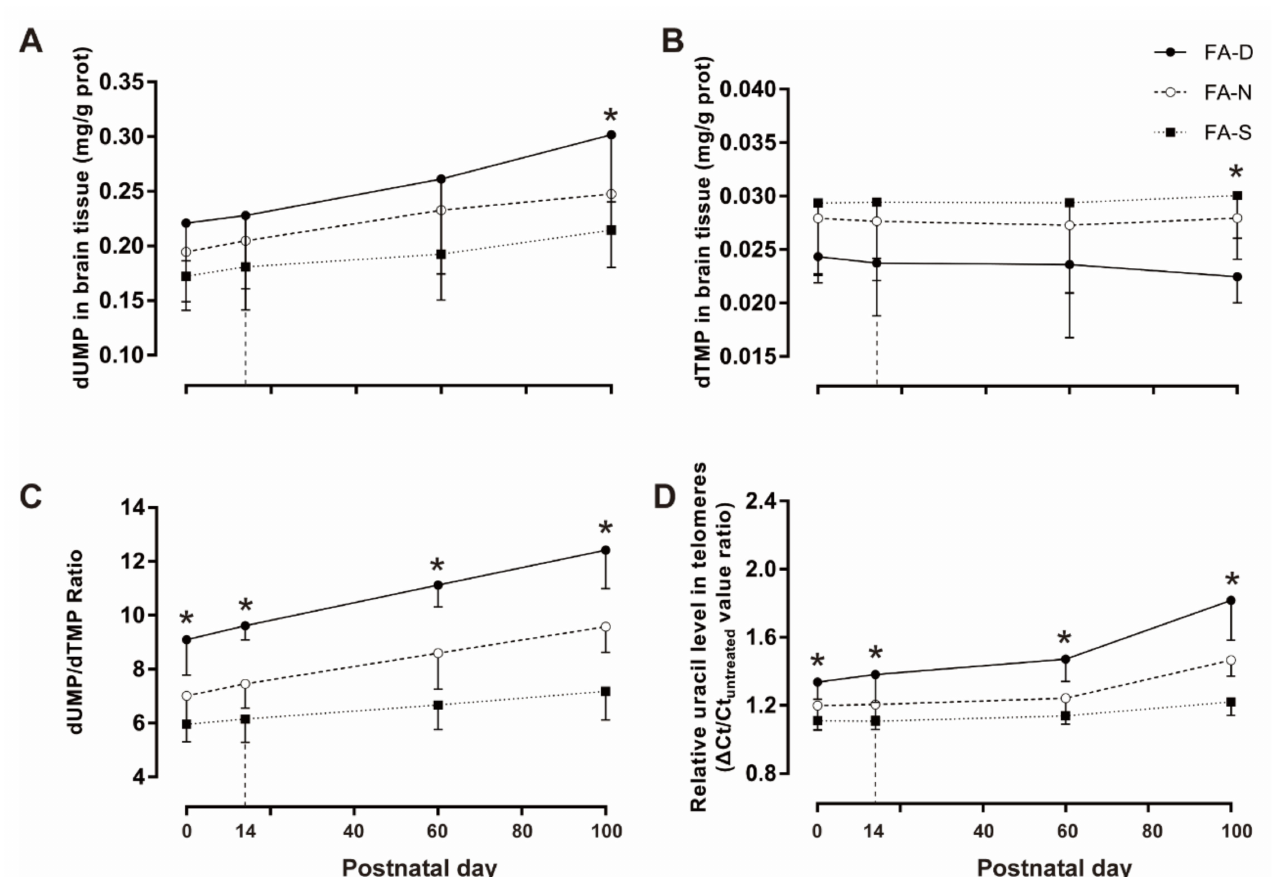
Figure 5. Folic acid supplementation reduced uracil misincorporation in telomeres in brain tissue of offspring. Dams and pups were fed as described in Figure 1. Brain dUMP level ( A ) and dTMP level ( B ) were determined by high-performance liquid chromatography, and dUMP/dTMP ratio ( C ) was calculated on PND0, PND14, PND60, and PND100. Relative uracil level in telomeres ( D ) was detected by quantitative PCR analysis on PND0, PND14, PND60, and PND100. Data are expressed as mean ± SD ( n = 8 brains/group). * Comparing with three groups at α = 0.05/(comparison